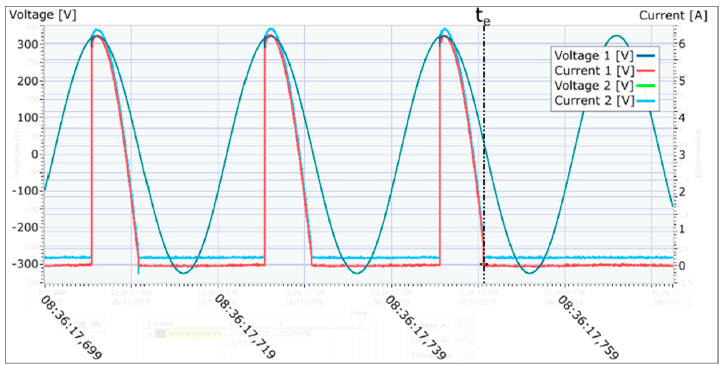
Figure 20. Instant ( t e ) at which the arc extinguished itself and the circuit opened (using the Bourns 2049-25 surge arrester).